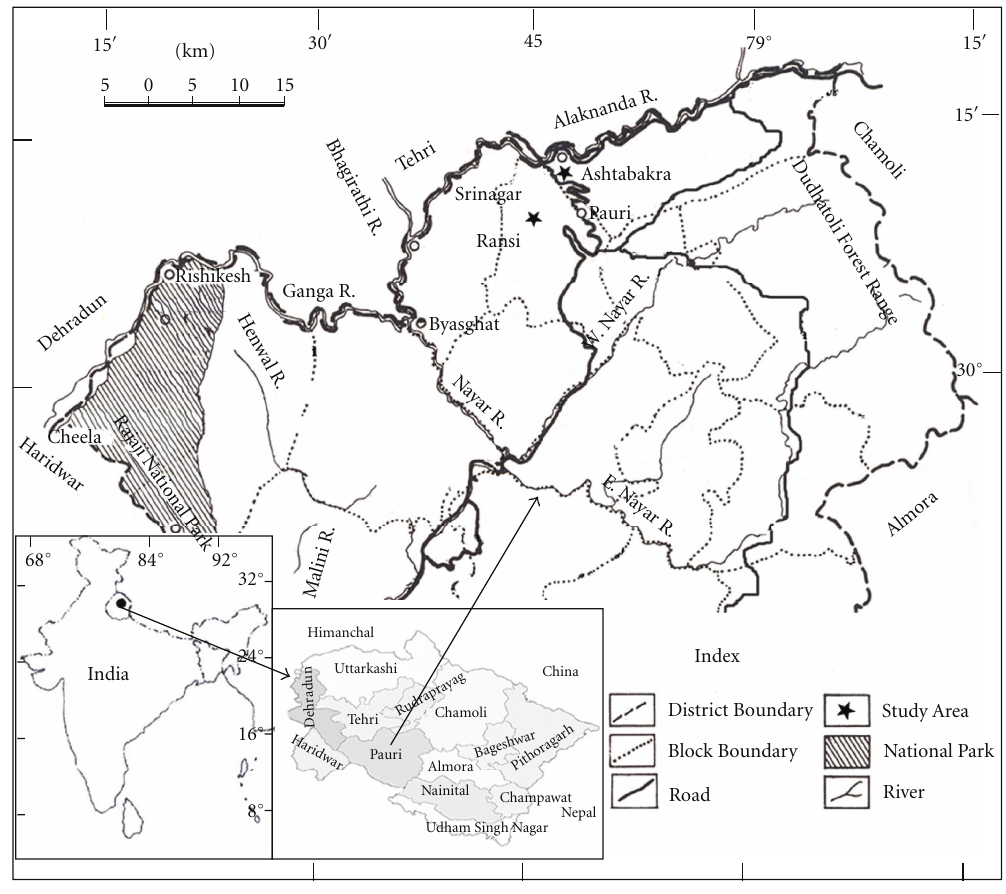
Figure 1: Location map of the study area. Table 1: Specifications of the